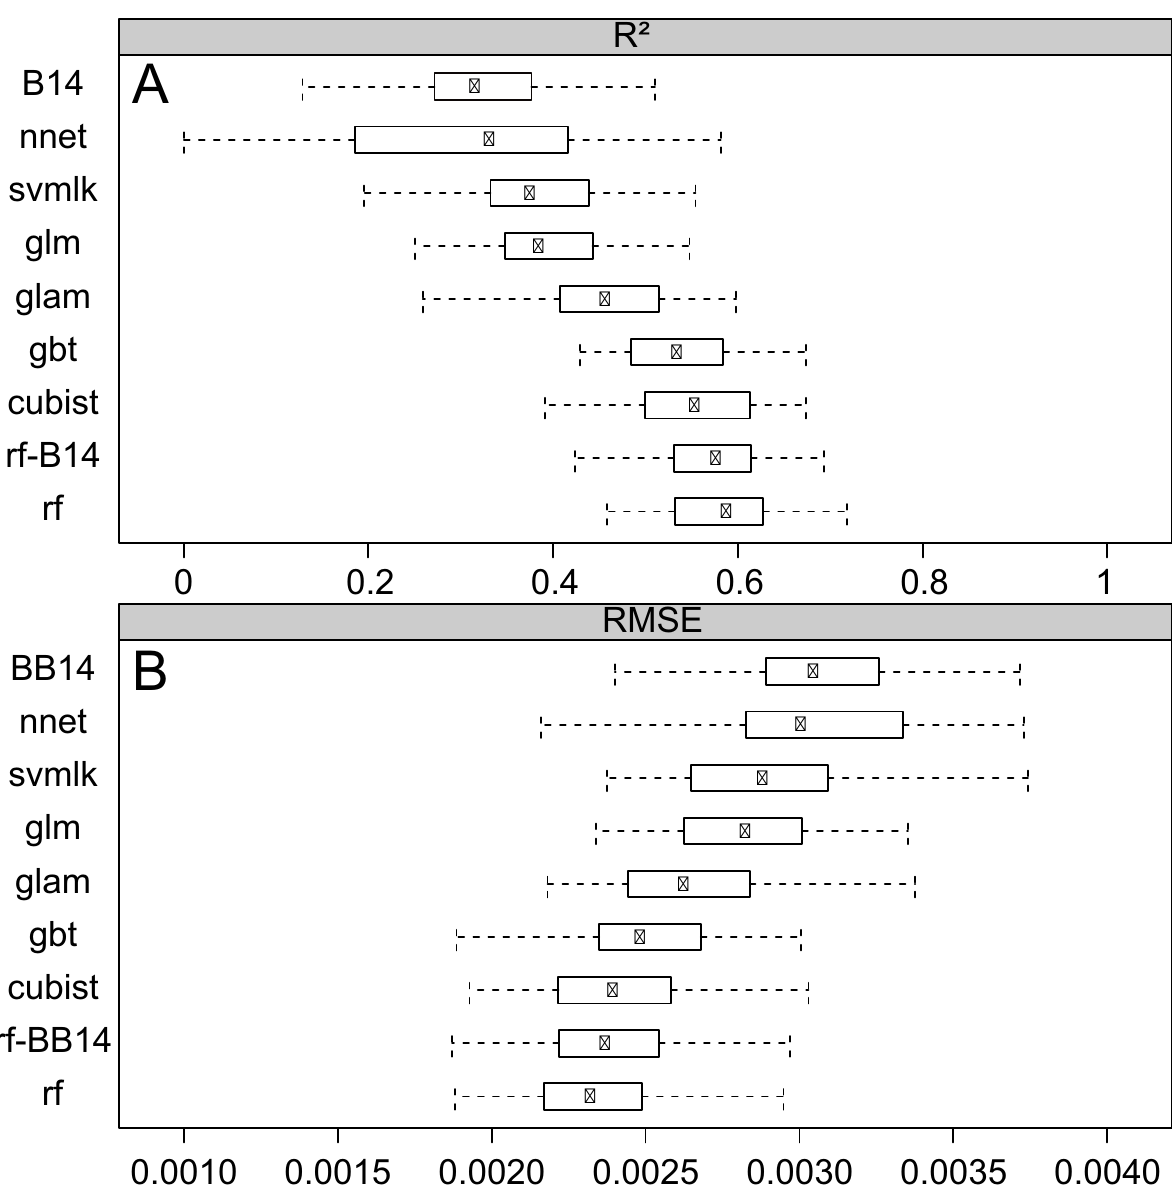
Fig 4. Model performance metrics. Summary of tested regression algorithm performance after 10-fold cross validation with 5 repetitions using: A. boxplots of the correlation coefficient (R 2 ) and B. boxplots of the root mean square error (RMSE). The regression methods are sorted by their predictive power from top to bottom. For model abbreviations please refer to Table 3. rf-B14: Random forest regression without Bataille et al. 2014 products; B14: Random forest regression using only Bataille et al. (2014)’s model products (Table 1).